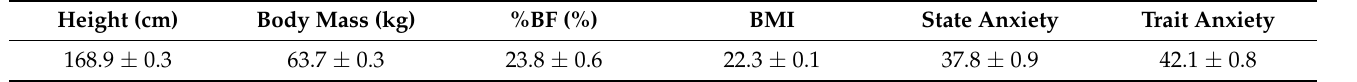
Table 1. Mean values of physical characteristics and state anxiety. Height (cm) Body Mass (kg) %BF (%) BMI State Anxiety Trait Anxiety 168.9 ± 0.3